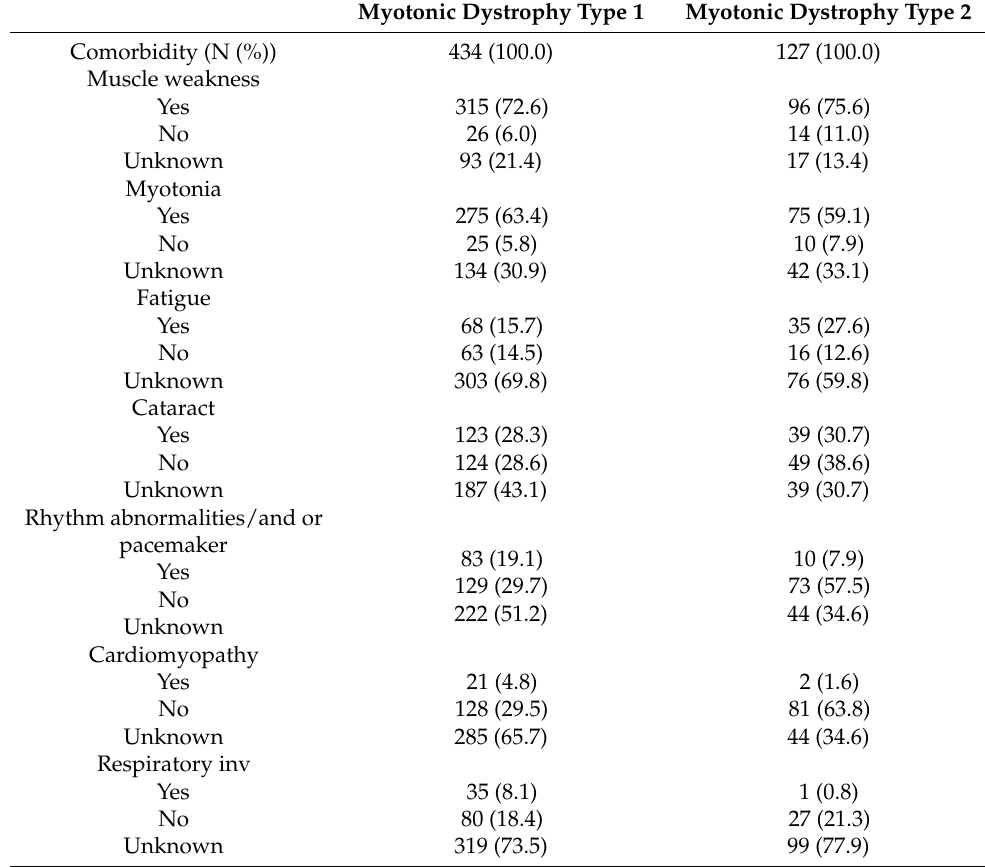
Table 4. Comorbidities in Myotonic Dystrophy Type 1 and Type